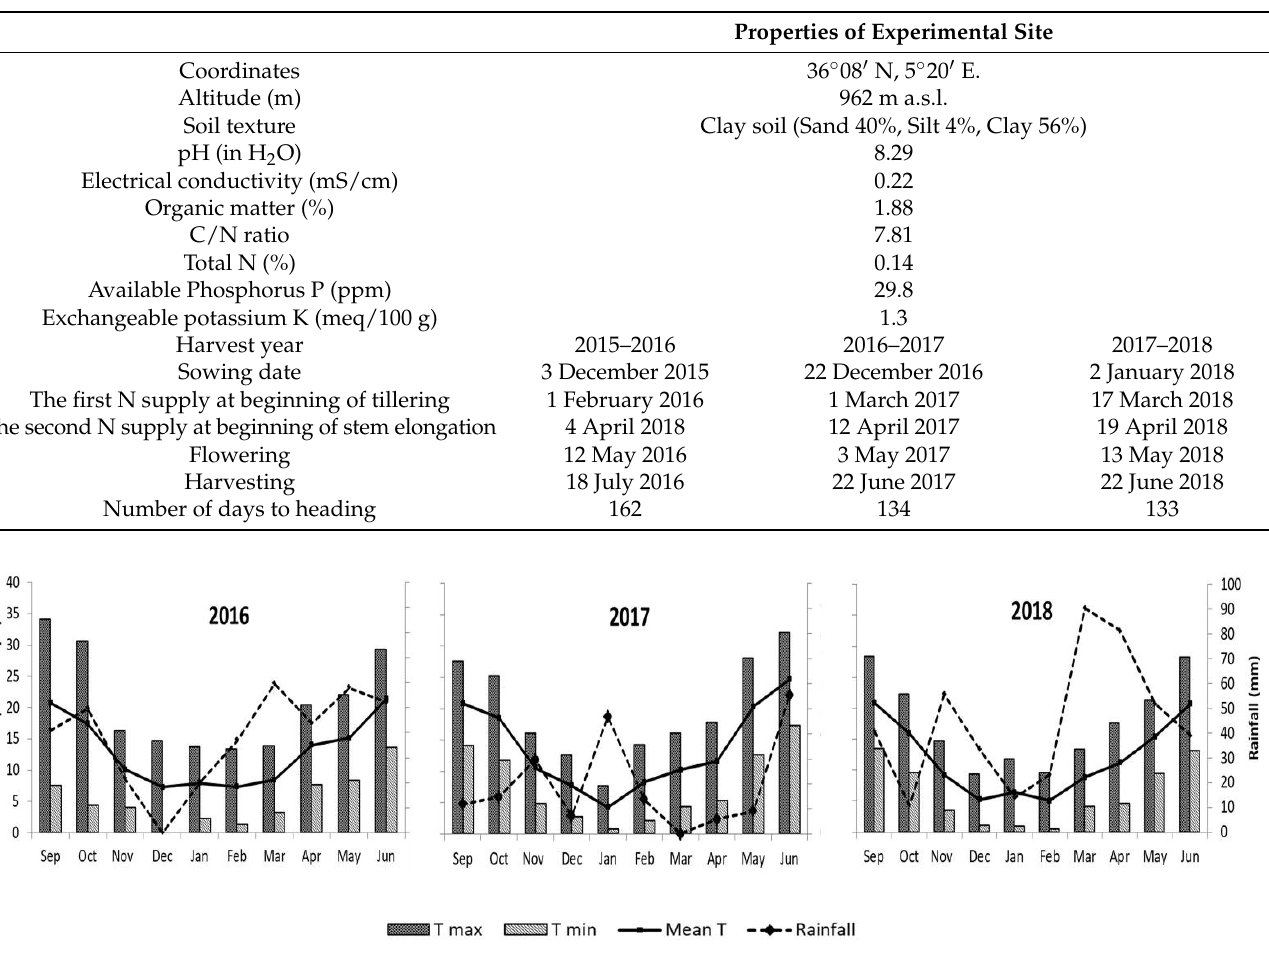
Table 1. Experimental details and dates of the main phenological stages during the three cropping seasons (in separate columns).